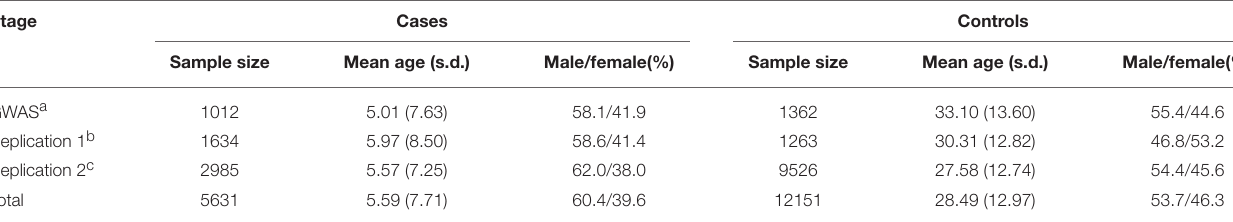
TABLE 1 | Summary of samples used in GWAS and replication